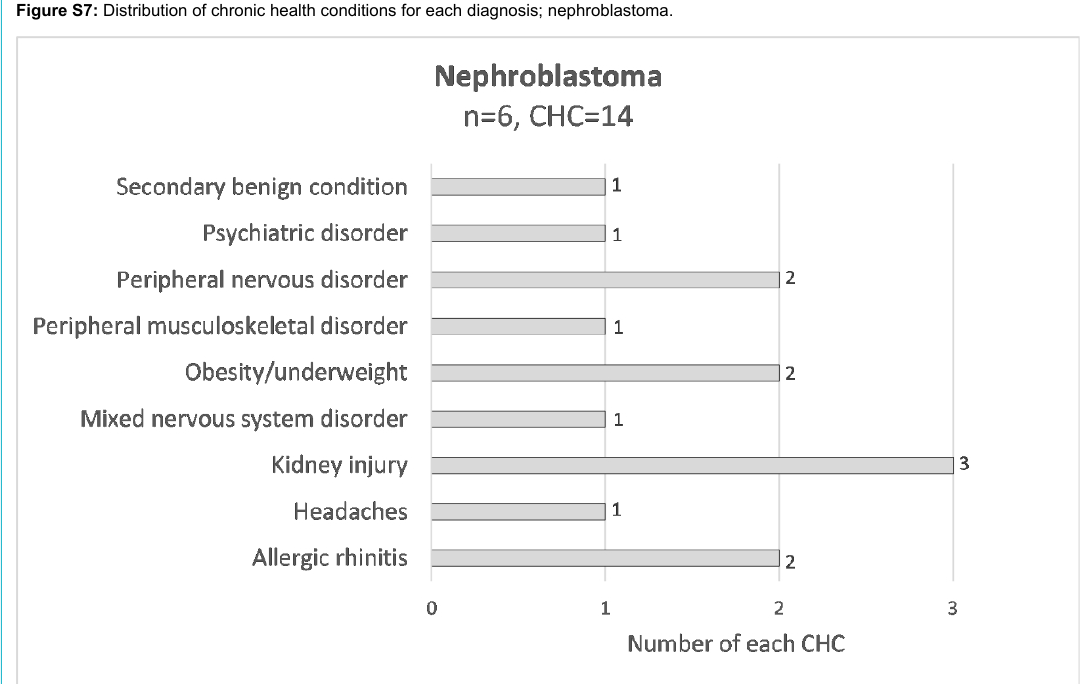
Figure S7: Distribution of chronic health conditions for each diagnosis;